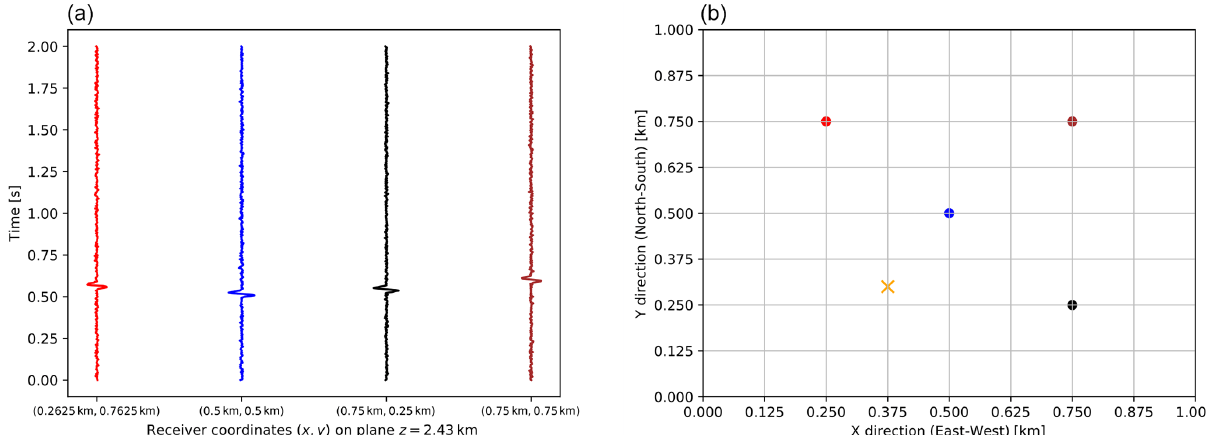
Figure 9. (a) Simulated noisy seismic traces recorded by the sensors at the seabed, with configuration shown in (b) . These recorded seis- mograms represent the data vector for our simulated posterior distribution inference. (b) Simulated receiver geometry in the detection plane z = 2.43km. The dots indicate the sensor locations, with colours matching those of the recorded seismic traces in (a) . The central receiver with coordinates (0.5km, 0.5km, 2.43km) is the one that we consider (similarly to D18) when we quantify the performance of our trained generative models in Table 1. We then include the other receivers when we demonstrate the effectiveness of our models in carrying out Bayesian inference of the coordinates of a simulated seismic event with coordinates (0.375km, 0.3km, 1.57km), whose projection on the detection plane is marked with an orange